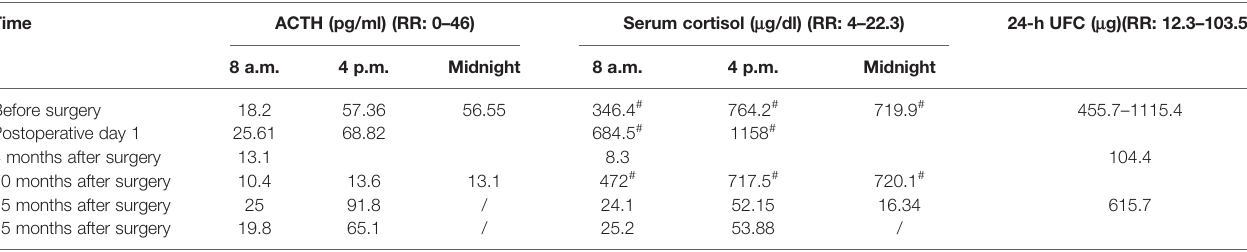
TABLE 1 | Laboratory results of the